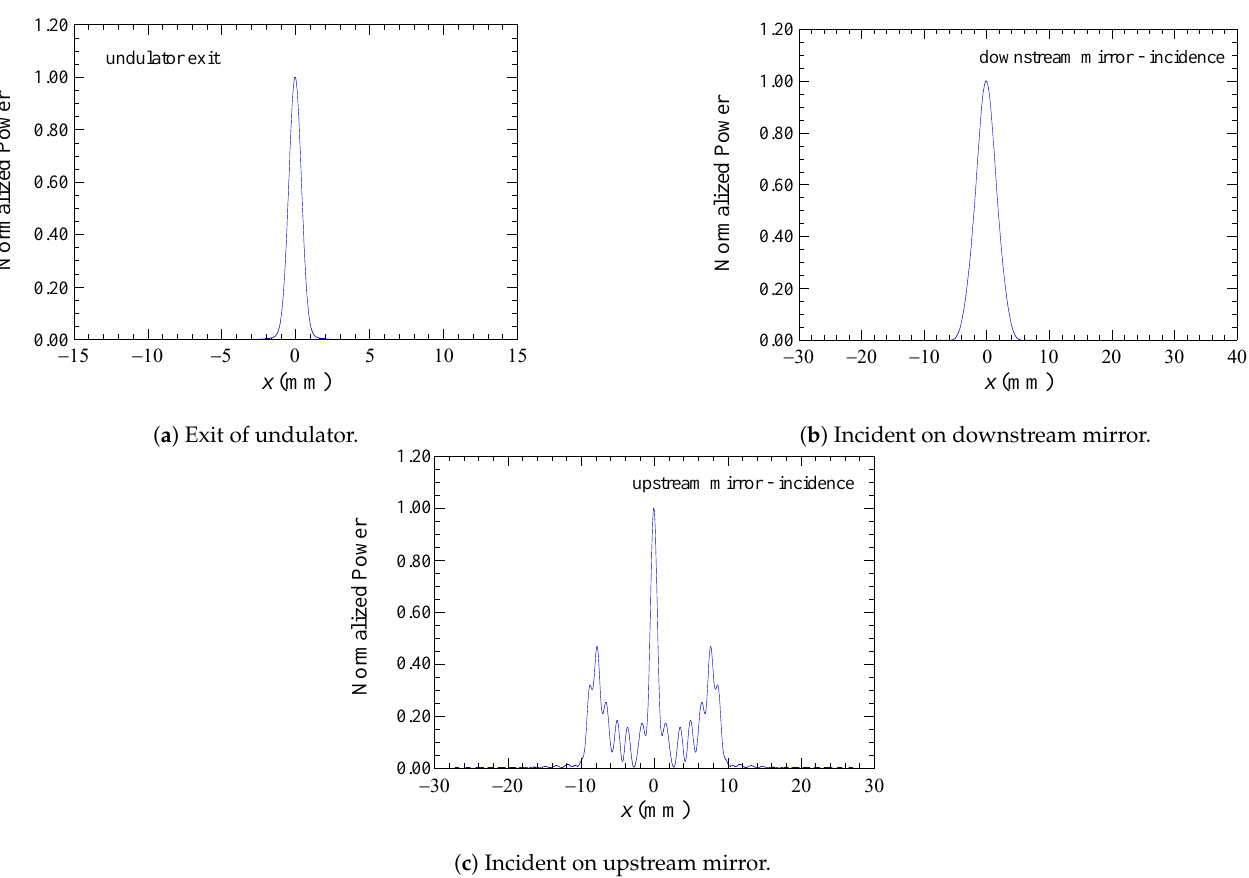
Figure 18. Cross-section of the optical field at various location on pass 60 for a cavity detuning ∆ L cav = − 18 λ and an undulator field strength of B u = 6.658 kG ( K rms = 1.055). The other parameters are given in Table